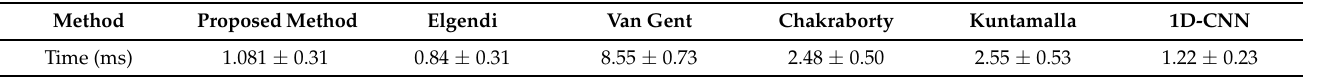
Table 3. Average processing time comparison of the proposed method and other existing